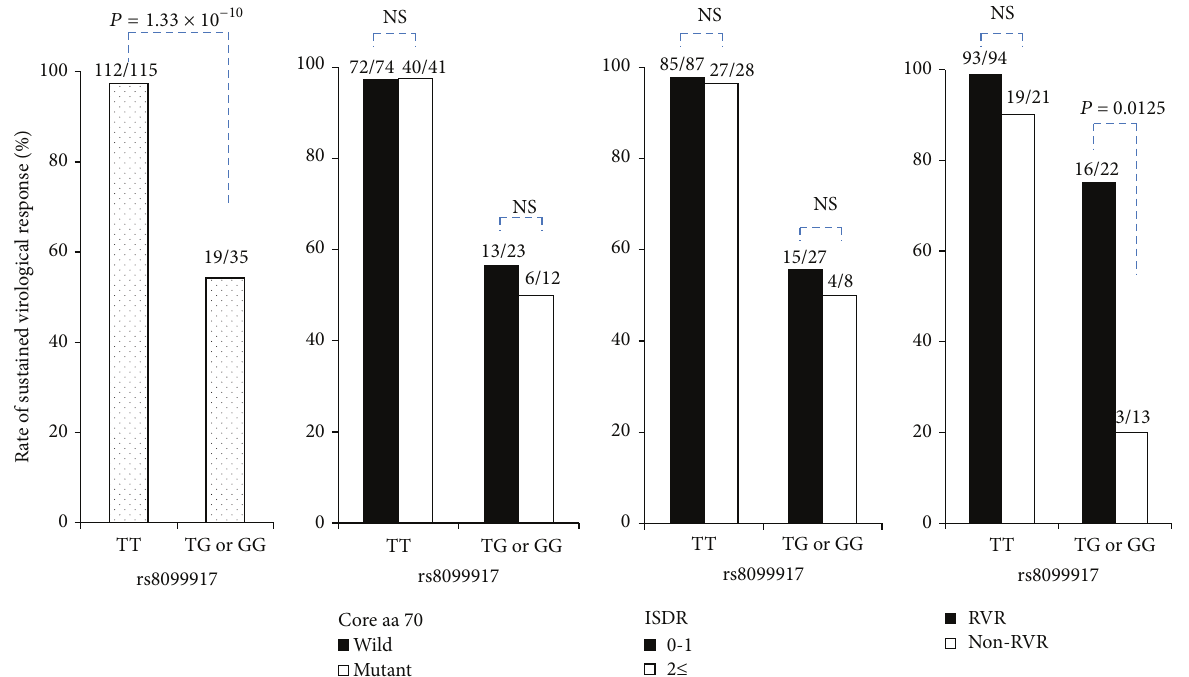
Figure 1: According to the genetic variation in rs8099917, near the IL28B gene, a significantly higher proportion of patients with the TT genotype showed a sustained virological response (SVR) than did patients with the TG or GG genotype. In contrast, based on the amino acid substitutions in the core region (amino acid 70) and interferon sensitivity-determining region (ISDR), there was no significant association between the SVR rate and these substitutions, irrespective of the rs8099917 genotype. Furthermore, the SVR rate was 98.9% in patients with the rs8099917 TT genotype who achieved rapid virological response (RVR), whereas the SVR rate was 23.1% among patients with the TG or GG rs8099917 genotype who did not achieve